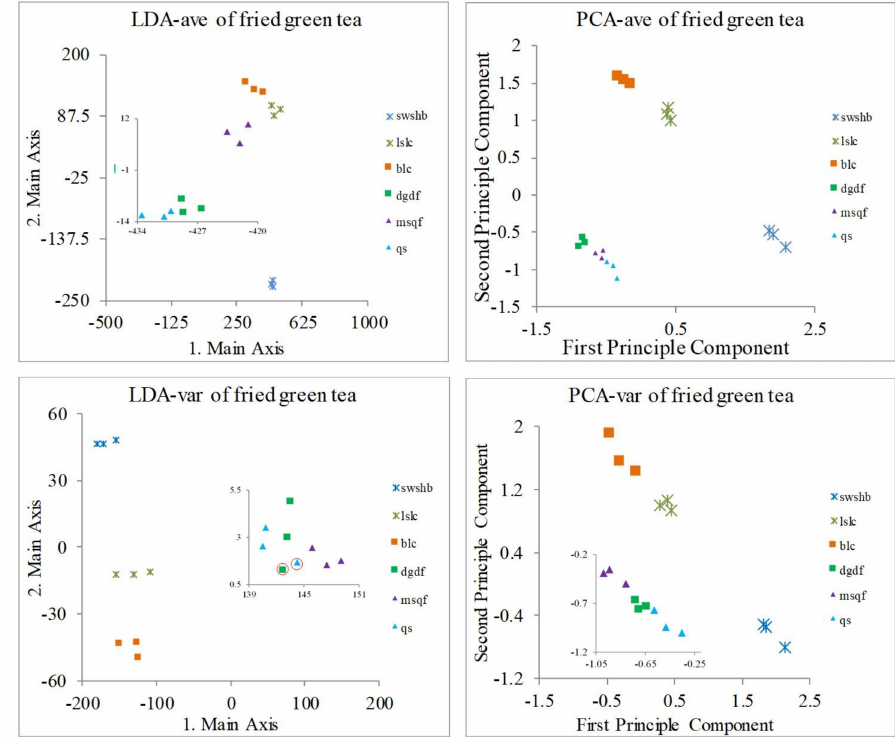
Figure 11. Classification results of fried green tea identified using LF.